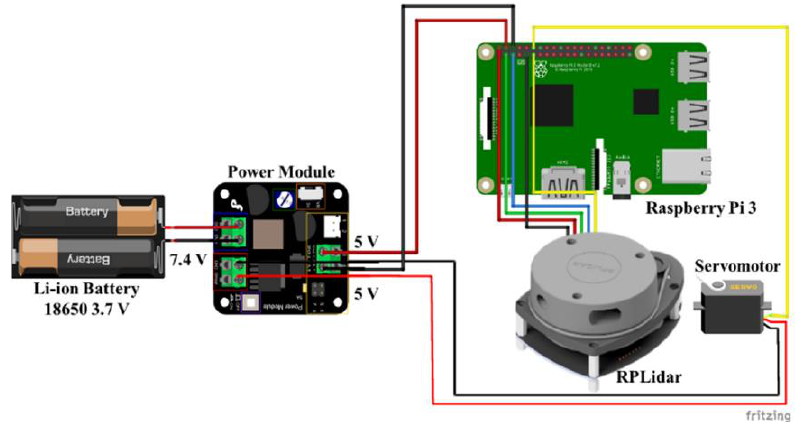
Figure 6. DFRobot 5-A Power Module DFR0205.